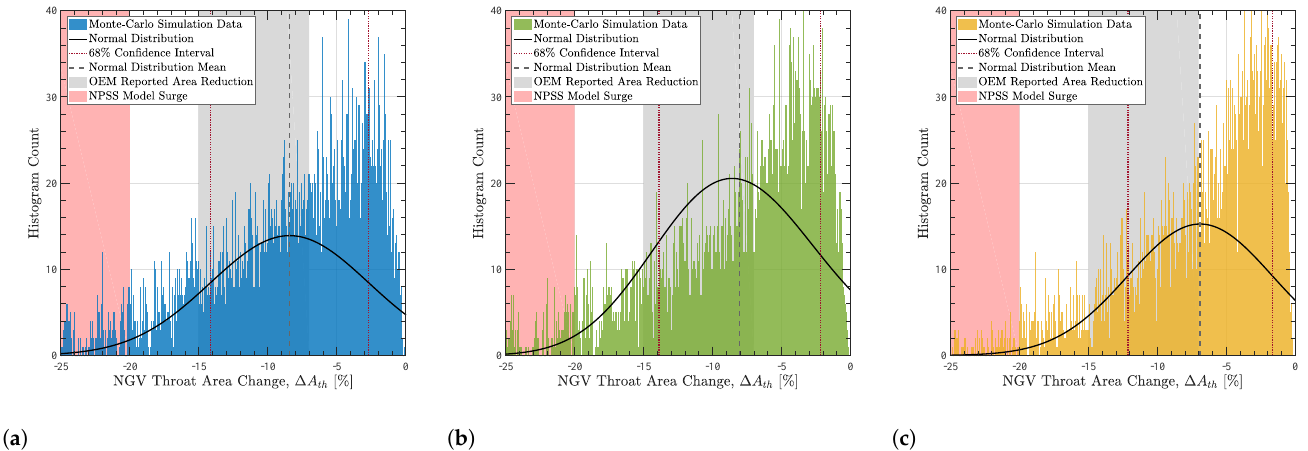
Figure 5. Predicted high-pressure turbine throat area change distributions for particle sphericities of ( a ) φ = 1.00, ( b ) φ = 0.75 and ( c ) φ = 0.54 comparing the predicted mean throat area change and 68% confidence interval with observations from the four engines involved in the Galunggung